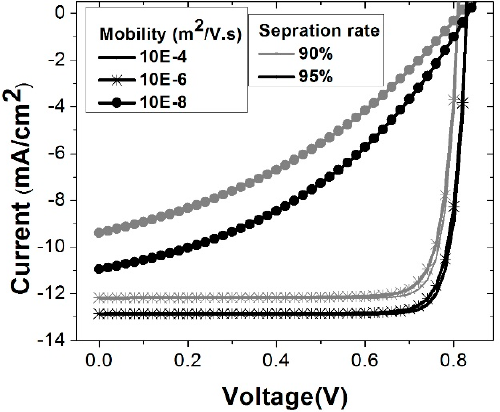
Figure 9. Current voltage characteristics of nominal and high carrier mobilities for efficient exciton separation mechanism.